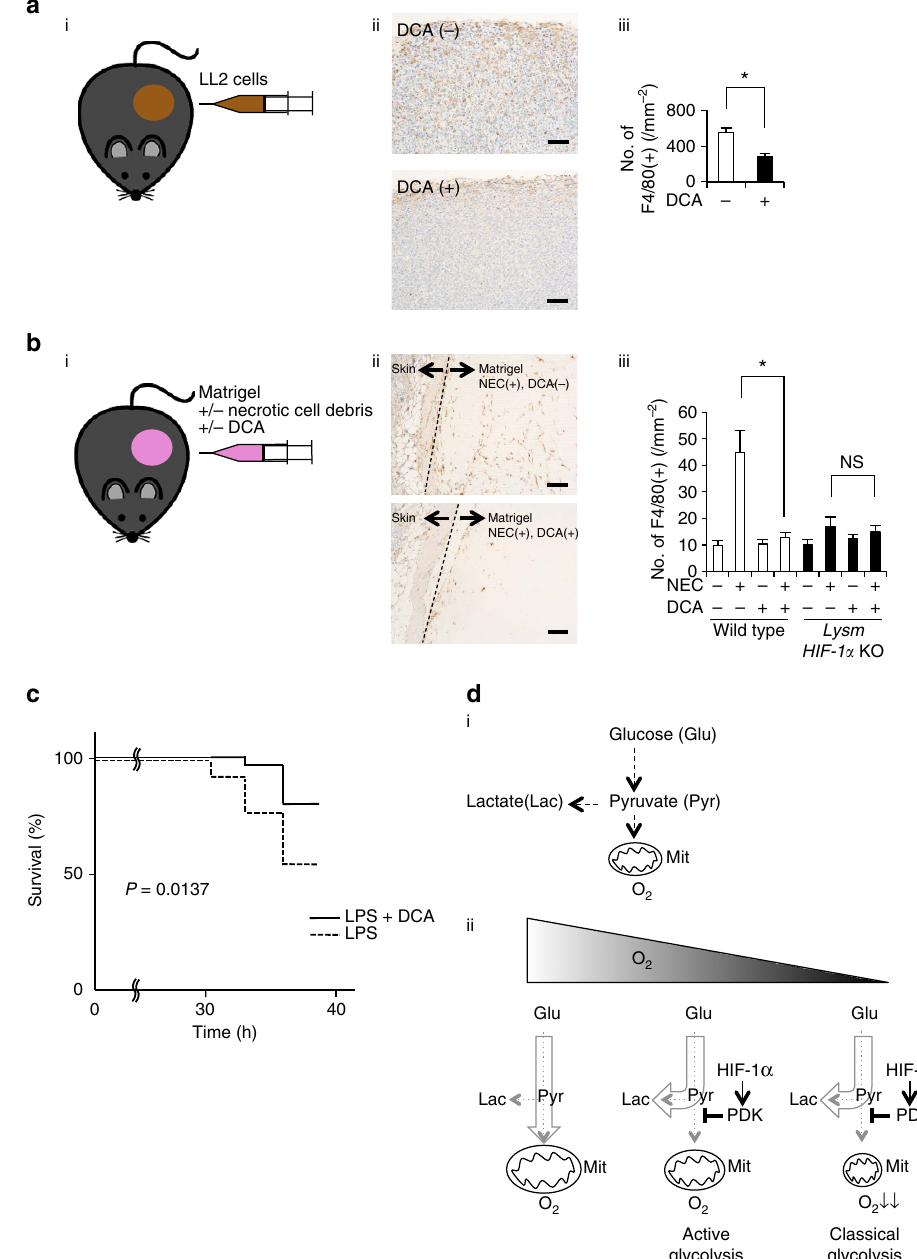
Figure 5 | DCA suppresses macrophage migration in vivo . ( a ) (i) LL2 cells (1 (cid:3) 10 6 ) were subctaneously injected in wild-type mice. (ii) Representative immunohistochemical staining of F4/80 (brown) in the isolated tumor from mice with or without DCA treatment (1.5gl (cid:2) 1 in drinking water for 8 days). (iii) The y axis of the graph represents the number of F4/80-positive stained macrophages per field (10 random fields per tumor). n ¼ 7 animals per group. ( b ) (i) Matrigel (500 m l) containing the supernatant of necrotic cell debris with or without DCA (10mM) was subctaneously injected in wild-type and LysM HIF-1 a KO mice. (ii) Representative immunohistochemical staining of F4/80 (brown) in the isolated matrigel in the presence or absence of DCA. (iii) The y axis represents the number of F4/80-positive macrophages per field (10 random fields per matrigel) in wild-type and LysM HIF-1 a KO mice. n ¼ 5 animals per group. ( c ) Mice were pre-treated with DCA (100mgkg (cid:2) 1 body weight) or PBS for 6h ( n ¼ 50 versus 50). Subsequently, endotoxin shock was induced by the intraperitoneal injection of lipopolysaccharide (LPS; Sigma; 40mgkg (cid:2) 1 body weight). ( d ) (i) The schema of glucose metabolism. (ii) The schematic representation of classical and active glycolysis in hypoxia. All graphs indicate average with s.d. Student’s t -test was performed to calculate P value. * P o 0.05; NS, not significant; wild-type, LysM-Cre (cid:2) / (cid:2) HIF-1 a flox/flox mice; LysM HIF-1 a KO, LysM-Cre þ / (cid:2) HIF-1 a flox/flox mice; NEC, the supernatant of necrotic cell debris; Scale bar, 100 m